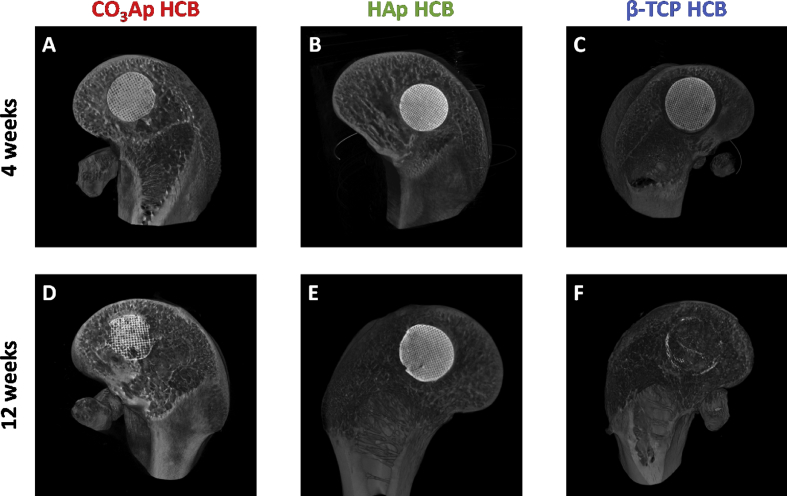
Examination of HCB resorption in vivo. μ-CT images of bone defects at POW 4 and 12 for CO3Ap (A, D), HAp (B, E), and β-TCP (C, F) HCBs, respectively.